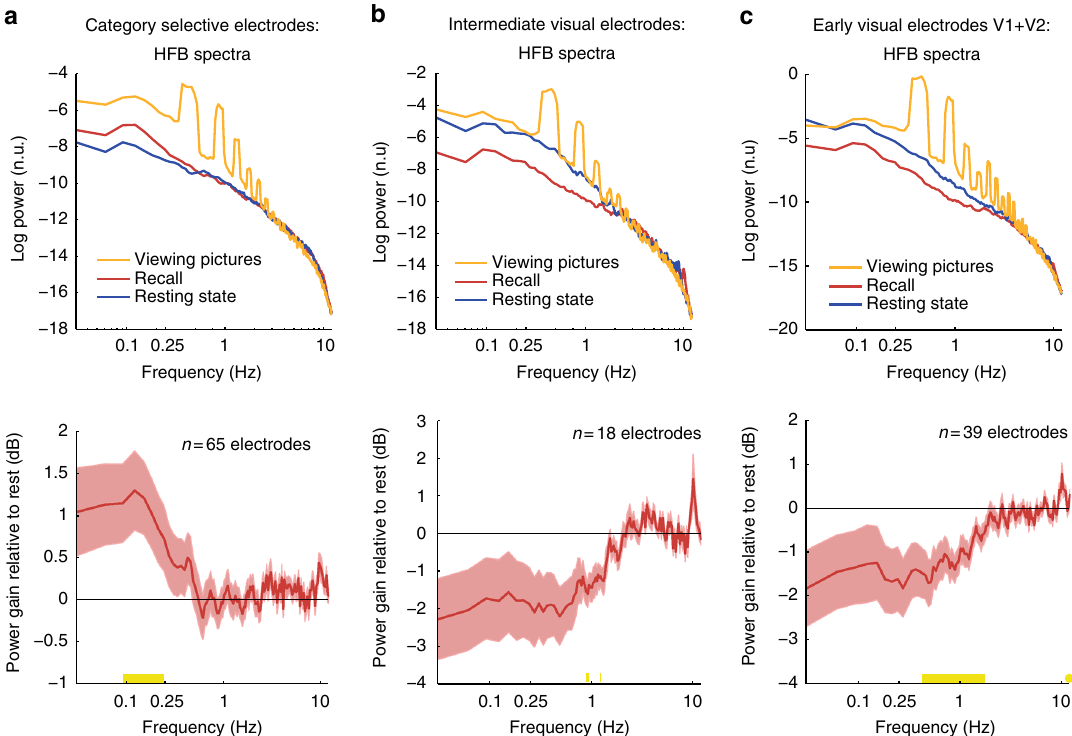
Fig. 7 Spectral analyses of ultra-slow HFB activity fl uctuations ( < 1 Hz). Spectral analysis of the HFB signal during the three main experimental conditions: resting-state (blue), free recall (red) and picture viewing (orange). Note the peak around 0.4 Hz and its harmonics during picture viewing, which re fl ects the rate of stimulus presentations. The bottom row depicts power gain relative to resting-state. a Category selective electrodes manifested an increase in the power of ultra-slow modulations of HFB amplitude during recall in the range of 0.09 – 0.25 Hz. Yellow marks on the x -axis represent the signi fi cant frequencies ( p < 0.05, FDR corrected, signed-rank test). b , c In contrast to category-selective electrodes, early visual electrodes showed a signi fi cant reduction in the power of ultra-slow HFB fl uctuation during free recall in a frequency range of 0.27 – 1.77 Hz; non-category-selective intermediate visual electrodes showed a similar trend with maximal power reduction between 0.88 and 1.25 Hz ( p < 0.05, FDR corrected, signed-rank tests). Shaded